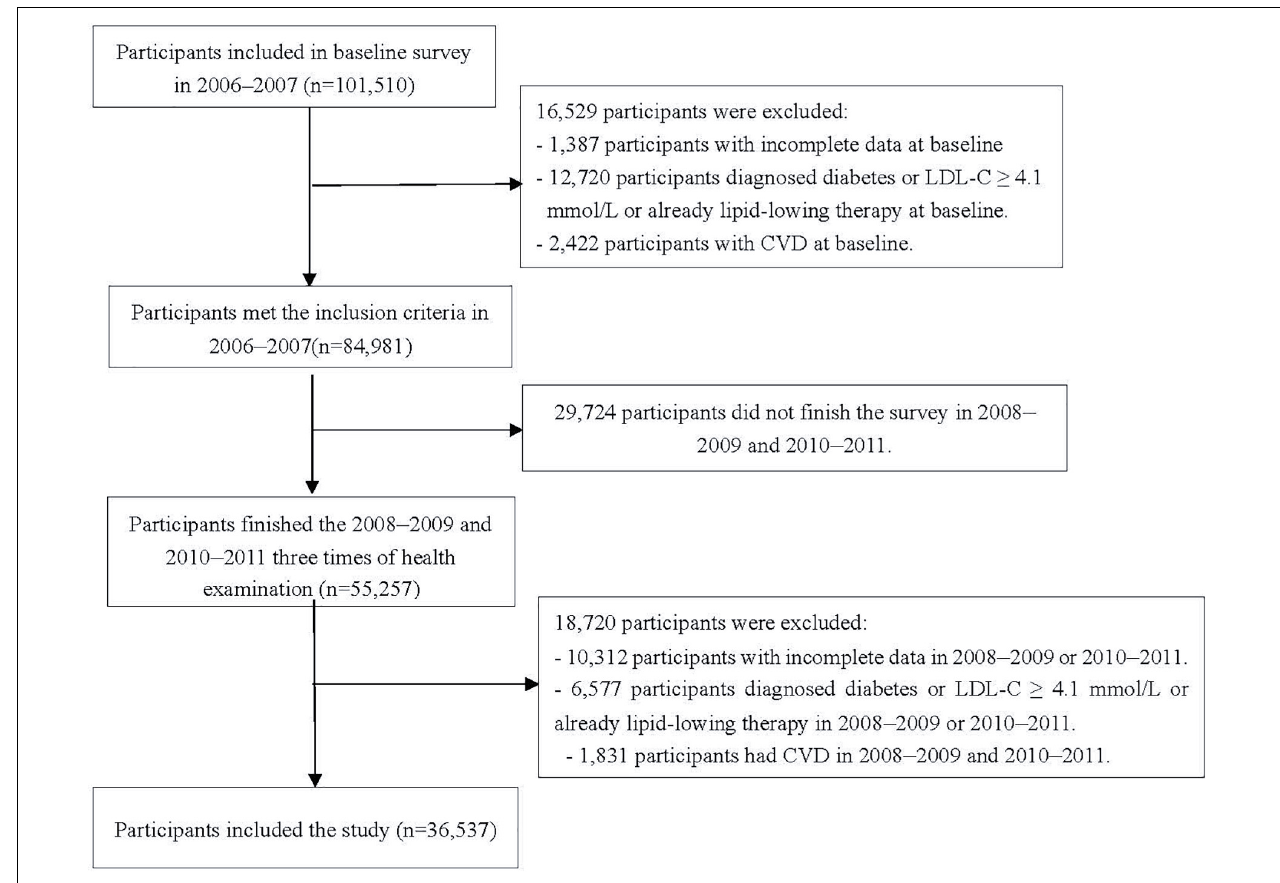
FIGURE 1 | Flowchart of this